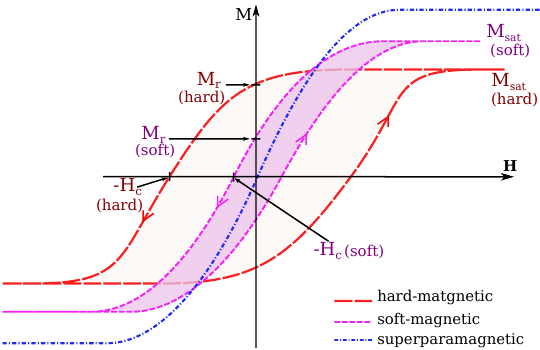
Figure 5. Typical hysteresis curves for ferromagnetic materials. The intercepts H c and M r are the intrinsic coercivity and magnetization remanence. Table 1. Typical properties of some soft-magnetic materials. (Adapted from